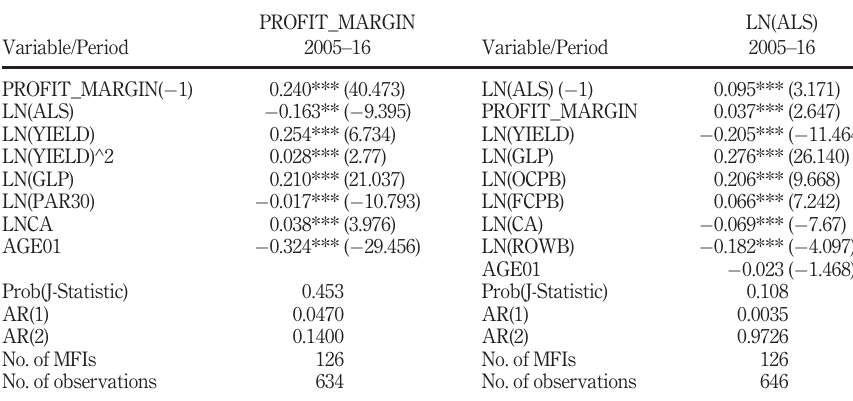
Table 3. Depth of outreach and pro fi t